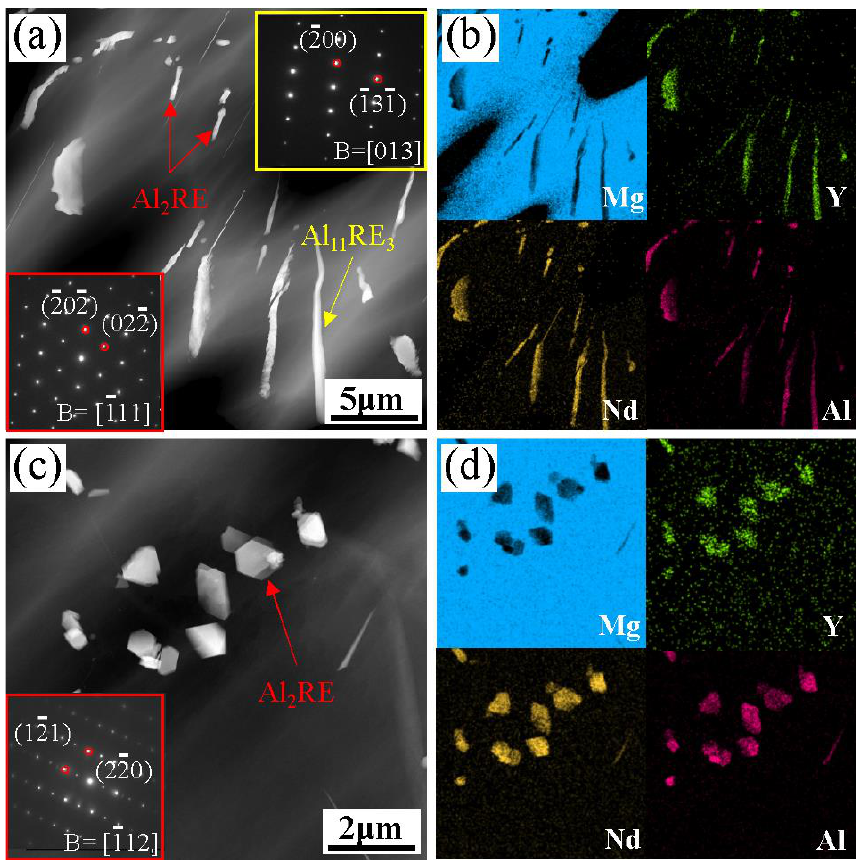
Figure 6. HAADF-STEM morphology, SEAD patterns, and EDS mapping of acicular phase and short rod-like phase in the Mg-3Y-4Nd-2Al alloy with different solution times: ( a , b ) 2 h; ( c , d ) 4 h.